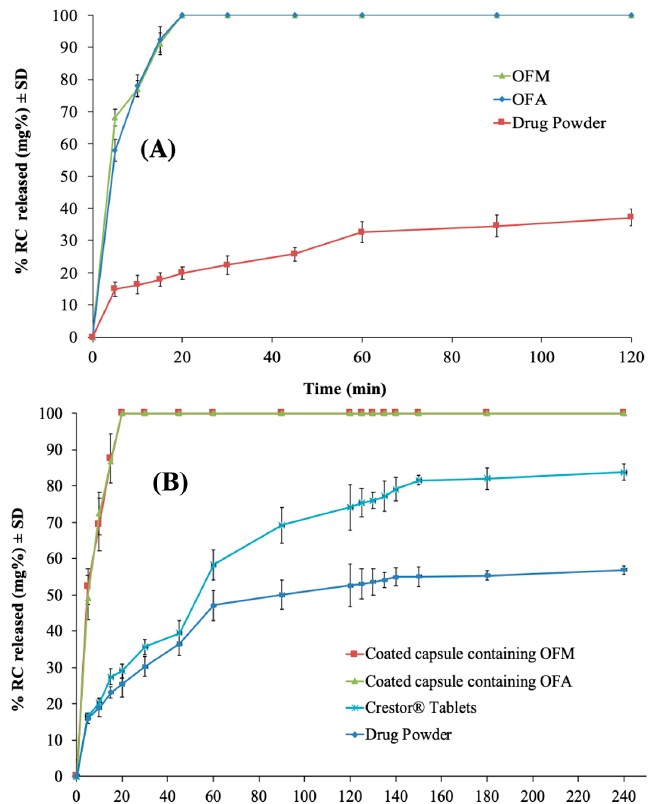
Figure 7. Release profile of RC from the optimized IFN formulations in 0.1N HCl ( A ), in comparison with the drug powder, and from the enteric-coated capsules containing the optimized formulations in citrate buffer (pH 6.6) ( B ), in comparison with the market product (Crestor ® Tablets) and the drug powder.